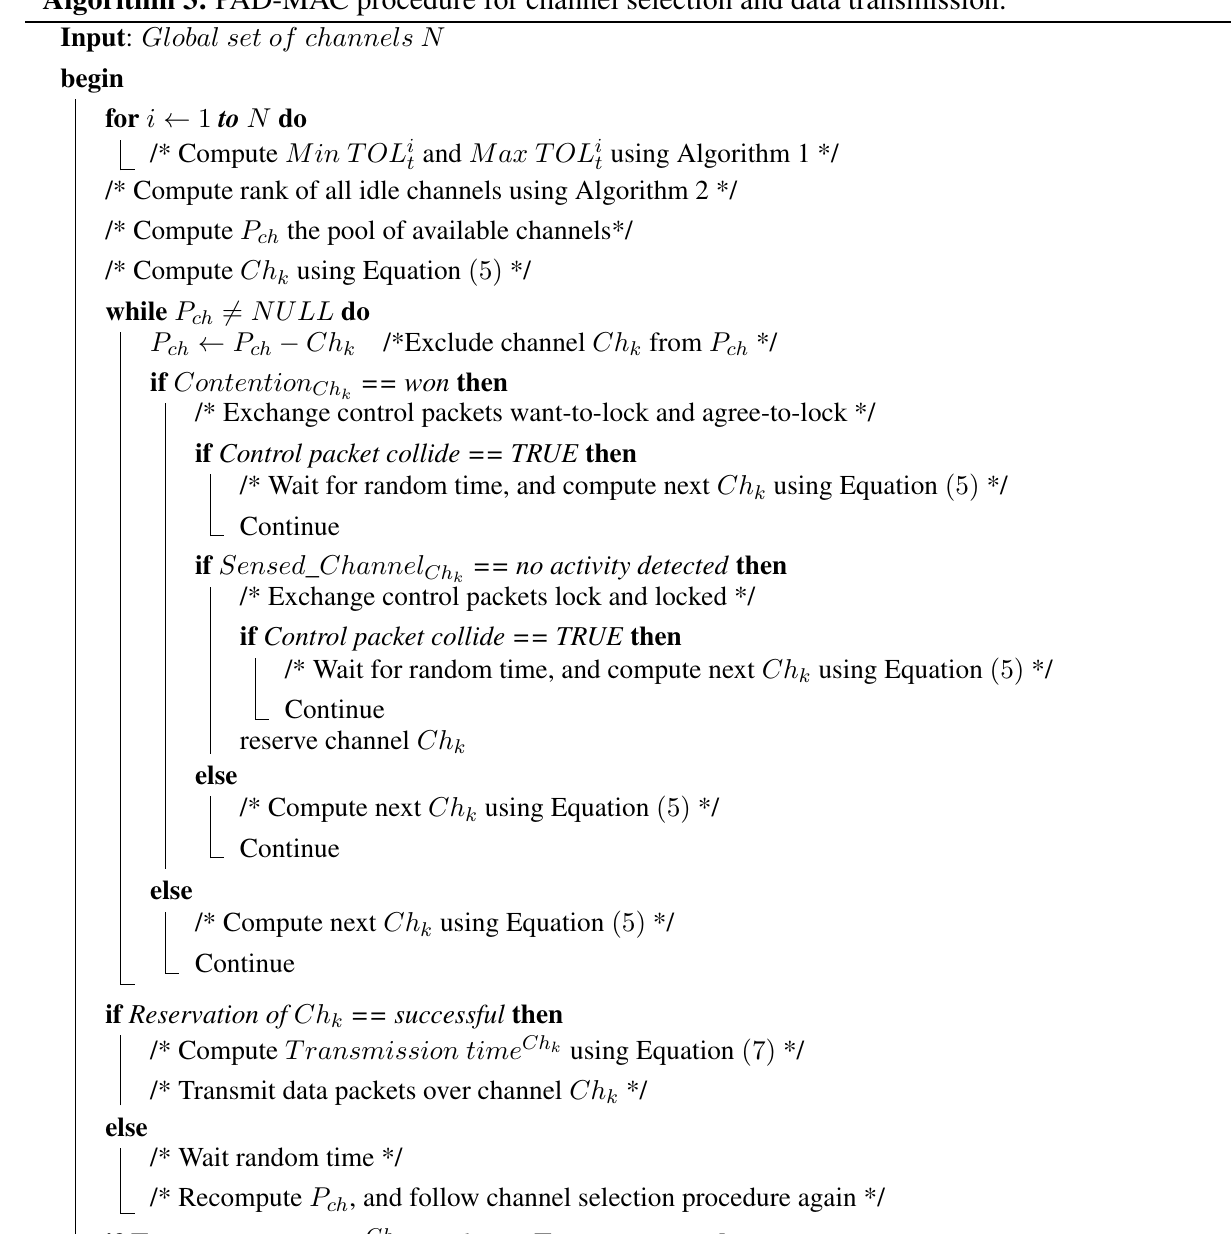
Algorithm 3: PAD-MAC procedure for channel selection and data